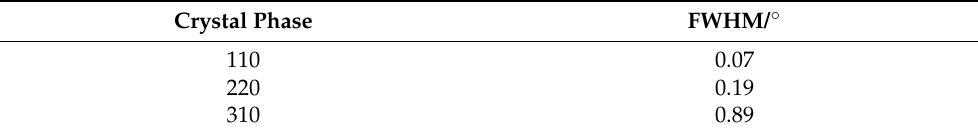
Figure 5. XRD diffraction patterns of the prepared CH 3 NH 3 PbI 3 /TiO 2 composite thin film. Table 4. The FWHM of MAPbI 3 phases 110, 220, and 310.